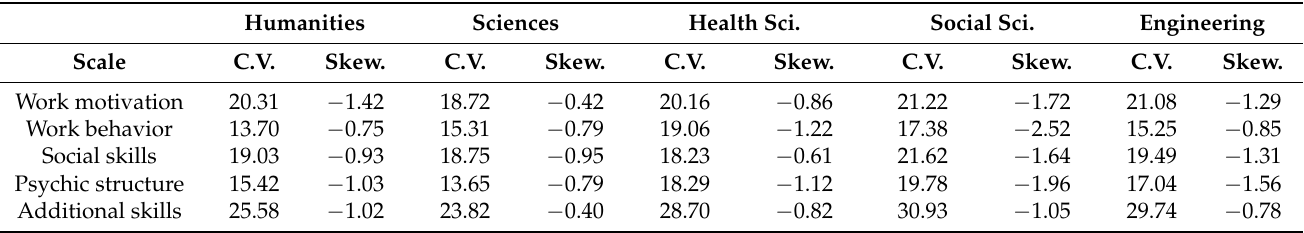
Table 12. Coefficients of variation (C.V., measured in percent) and skewness (Skew.) of the overall answers of the different scales of the questionnaire when the sample is differentiated by area of